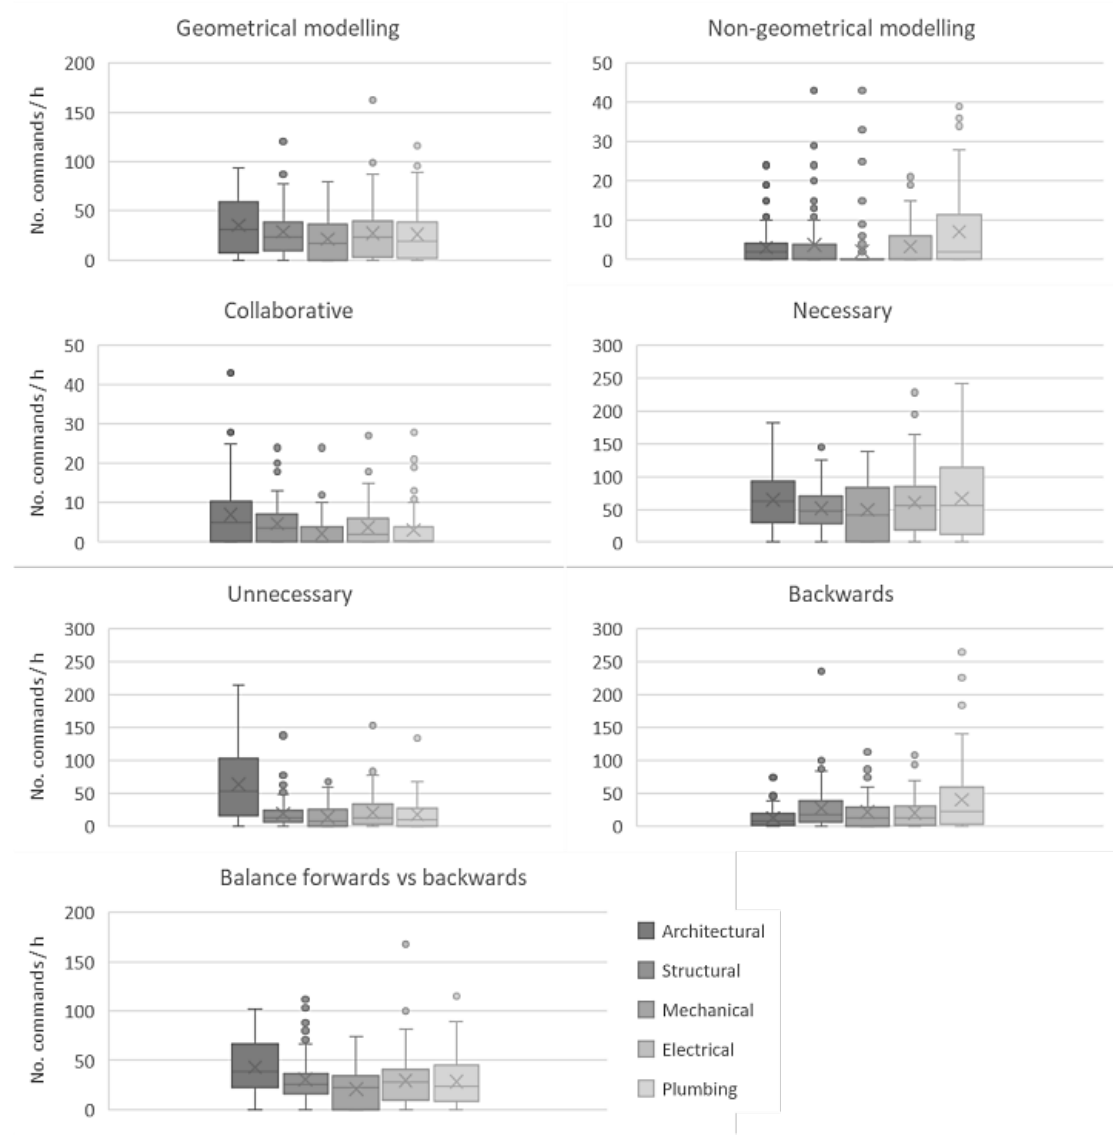
Figure 6. Distribution of the command execution rates for each sub-category by specialty during the experiment´s 90 time periods.